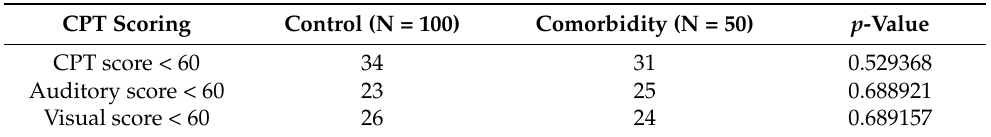
Table 4. Association of overall CPT, auditory, or visual component scores below 60 as compared to principal diagnosis.